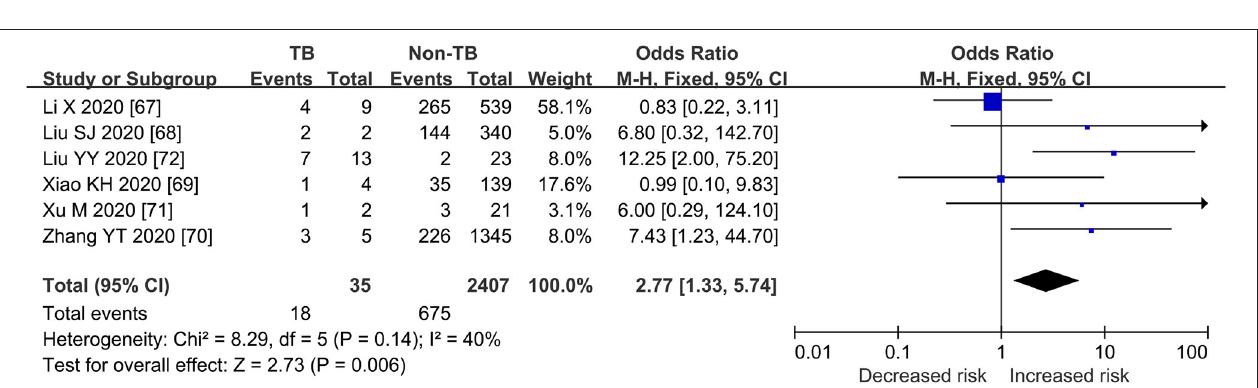
FIGURE 3 | Forrest plot demonstrating the pooled ORs of severe cases in COVID-19 patients with tuberculosis. ORs, odds ratios; TB, tuberculosis; CI, confidence interval; events refer to the occurrence of severe